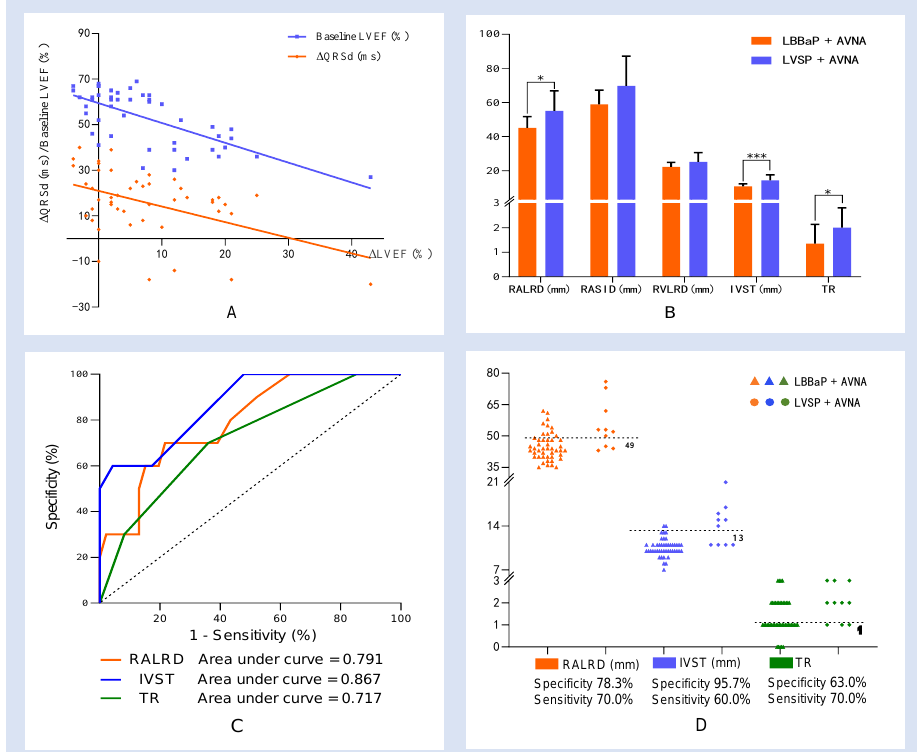
Figure 2. ( A ) Baseline LVEF and ΔQRSd predicted the magnitude of improvement of LVEF at 1 year after LBBaP and AVNA. The multiple linear regression equation is “ΔLVEF = 44.295 -0.463 * baseline LVEF- 0.182 * ΔQRSd”, indicating that the lower the baseline LVEF, the smaller the QRSd broaden- ing, or the more obvious the QRSd shortening at implantation, the more significant the improve- ment of LVEF at 1-year follow-up. ( B ) Comparison of baseline Echo parameters between LBBaP and LVSP groups. There were statistical differences in RALRD, IVST, and the degree of TR between the two groups. ( C , D ) Scatter plots and ROC curve. The cut of values of RALRD, IVST, and the degree of TR were 49mm, 13mm, and 1(mild regurgitation), respectively. Additionally, the AUC values were 0.791, 0.867 and 0.717, respectively. When the RALRD > 49 mm, IVST > 13 mm, and the degree of TR were moderate or severe, LBBaP was more likely to fail. LVEF = left ventricular ejection frac- tion, IVST = interventricular septum thickness, TR = tricuspid regurgitation, RALRD = right atrial left-right diameter, LBBaP = left bundle branch area pacing, LVSP = left ventricular septal pacing, AVNA = atrioventricular node ablation, Echo = echocardiography , ΔLVEF = the magnitude of im- provement of LVEF at 1-year after LBBaP and AVNA, ΔQRSd = QRS duration change at implanta- tion, AUC = area under ROC curve, ROC = receiver operating characteristic curve, AUC = area under the curve. *** p < 0.001, * p < 0.05; the degree of tricuspid regurgitation defined as 0-None, 1-Mild, 2- Moderate; and 3-Severe.